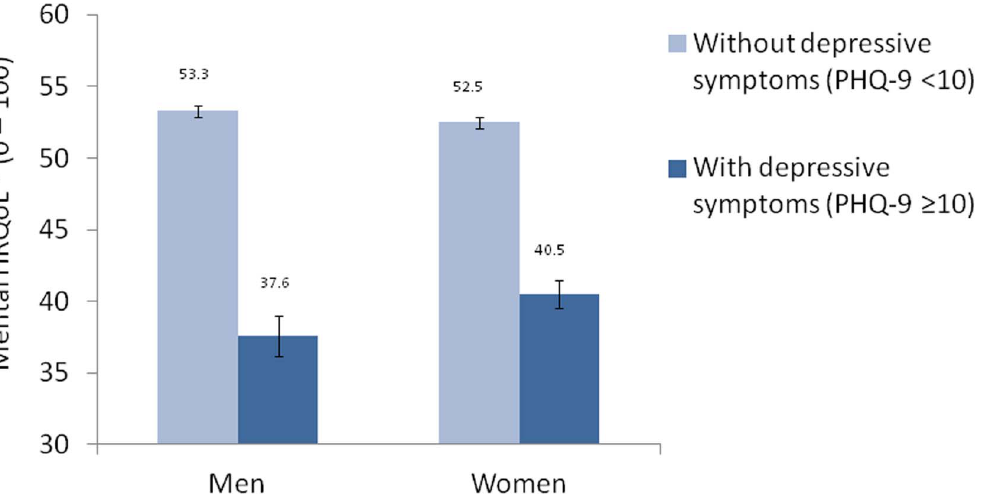
Figure 2. Mental health related quality of life (Mental HRQoL, bars) and their 95% confidence intervals in participants with depressive symptoms (PHQ-9 $ 10, 111 men and 228 women) and without depressive symptoms (PHQ-9 , 10, 7,196 men and 8,492 women) by sex. *Adjusting for age, education level, drinking status, physical activity level, body mass index, number of chronic diseases, life stress, and neighborhood cohesion.